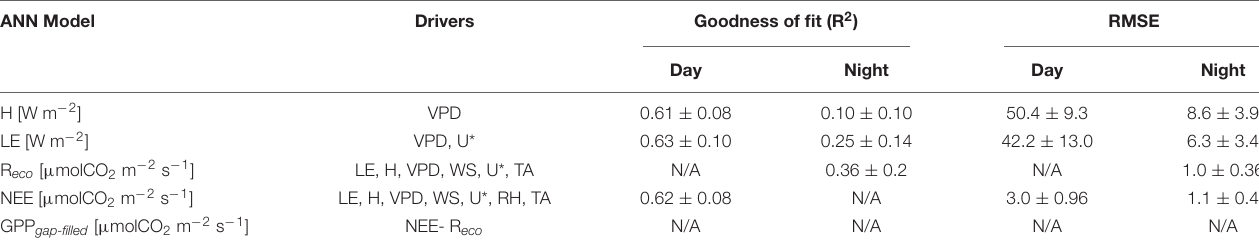
The table includes goodness-of-fit statistics for ANN models used to gap fill fluxes. Values represent averages ± standard deviation of R 2 and root mean square error (RMSE) across all sites and years.